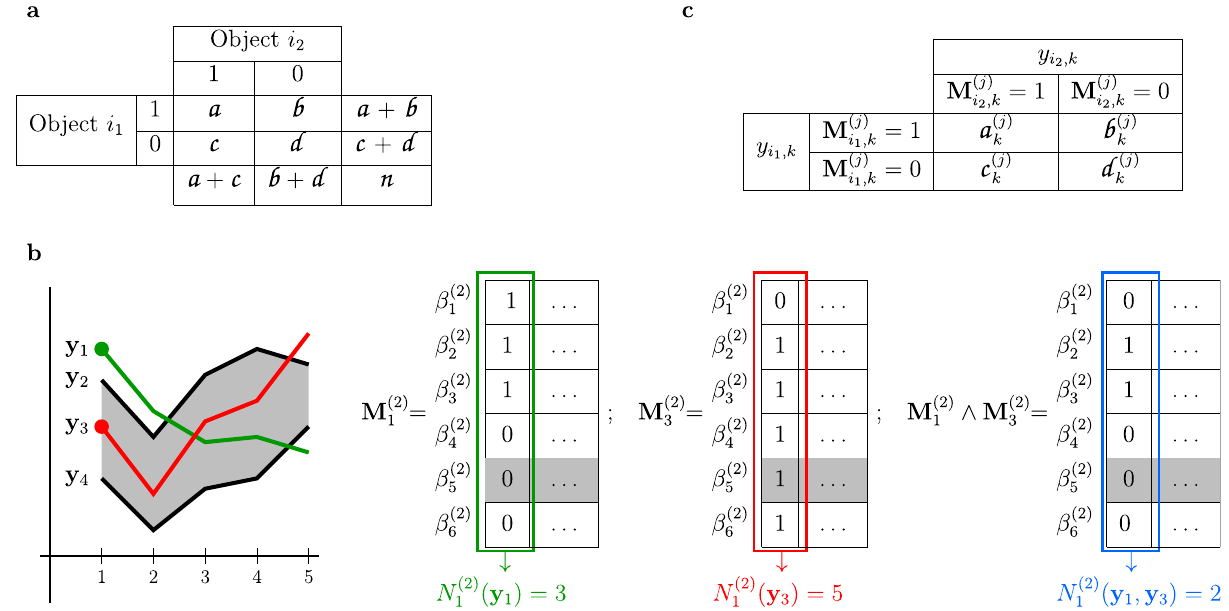
Figure 1. Computation of binary matrices. ( a ) Contingency table for binary vectors x i 1 and x i 2 , associated to objects i 1 and i 2 respectively. ( b ) Representation of four quantitative observations with five variables that define ( 2 ) ( 2 ) ( 2 ) ( 2 ) ( 2 ) six possible 2-bands, namely, β 5 = [ y 2 ; y 4 ] , 3 = [ y 1 ; y 4 ] , β 1 = [ y 1 ; y 2 ] , β 2 = [ y 1 ; y 3 ] , β 4 = [ y 2 ; y 3 ] , β 2 ) ( 2 ) β ( 5 . The first coordinate of curve y 1 6 = [ y 3 ; y 4 ] . The gray region between the black curves is the band β ( 2 ) (green dot) is outside the band; this corresponds to a 0 in the entry (5,1) of its associated Boolean matrix M 1 . ( 2 ) The first coordinate of curve y 3 , in red, is inside the band; the entry (5,1) in matrix M 3 is 1, accordingly. The corresponding Boolean product is 0, meaning that the band does not include both coordinates. ( c ) Binary contingency table for coordinate k and the number j of curves forming a band, constructed from the matrices sketched in ( b